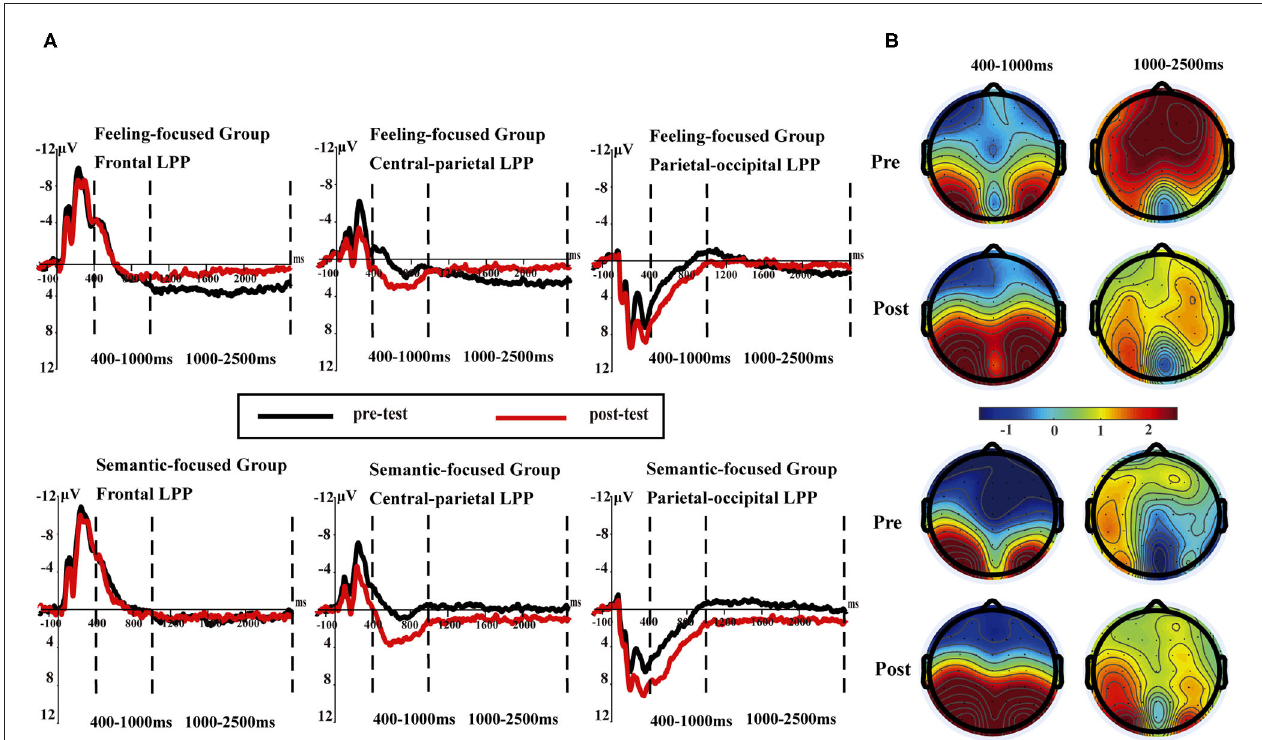
FIGURE 3 | (A) Late positive potentials averaged at three sites (F1, FZ, F2; CP1, CPz, CP2; and PO3, POz, PO4) in pre- and post-tests for the feeling-focused (upper panel) and semantic-focused groups (lower panel) in 400–1,000 and 1,000–2,500ms, respectively. (B) The scalp distribution of pre- and post-tests in 400–1,000 and 1,000–2,500ms for both